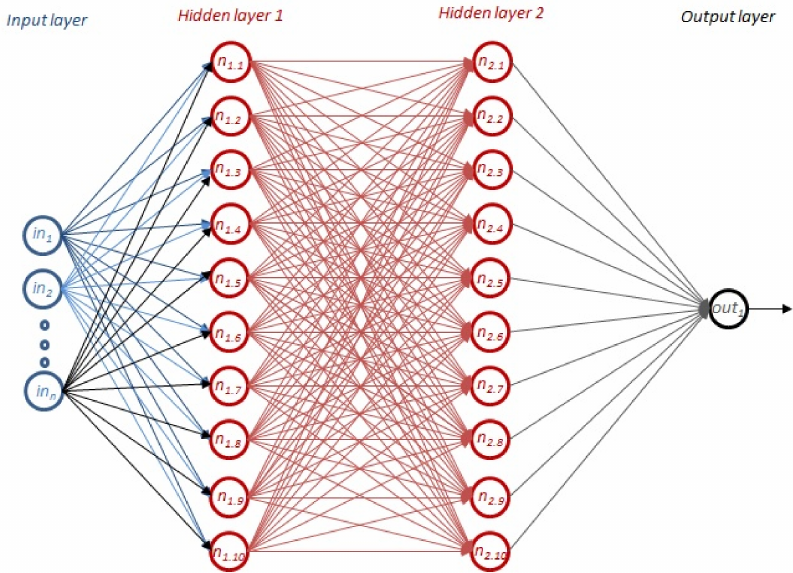
Figure 5. Diagram of a MLP neural